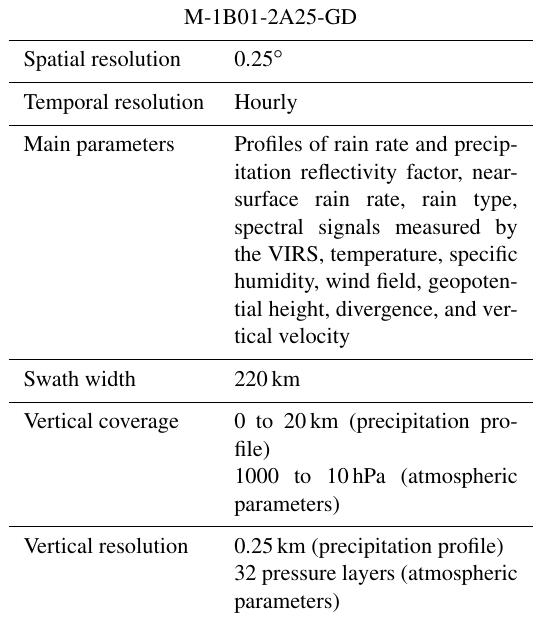
Table 1. Critical information on